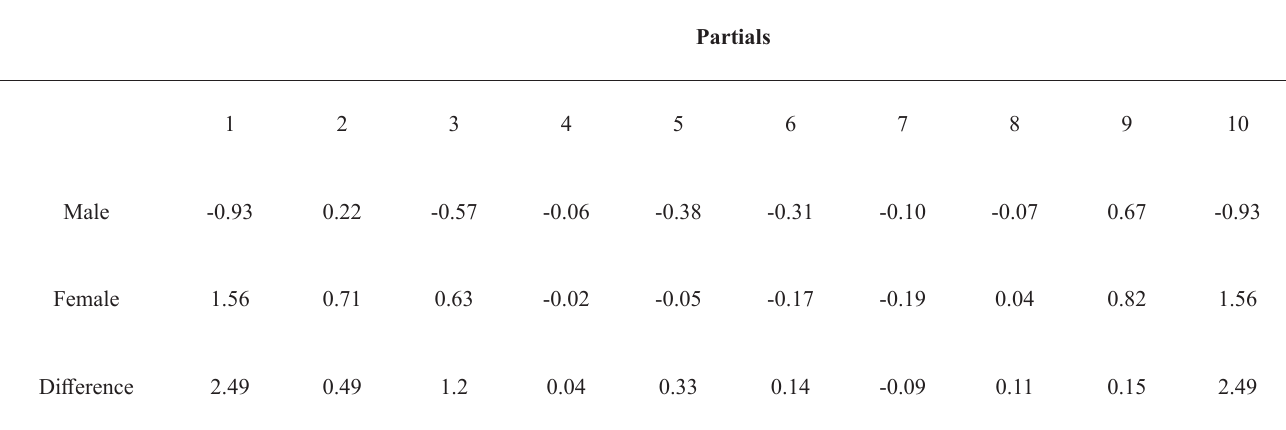
Table 2 - Partial effect size in the male e female group